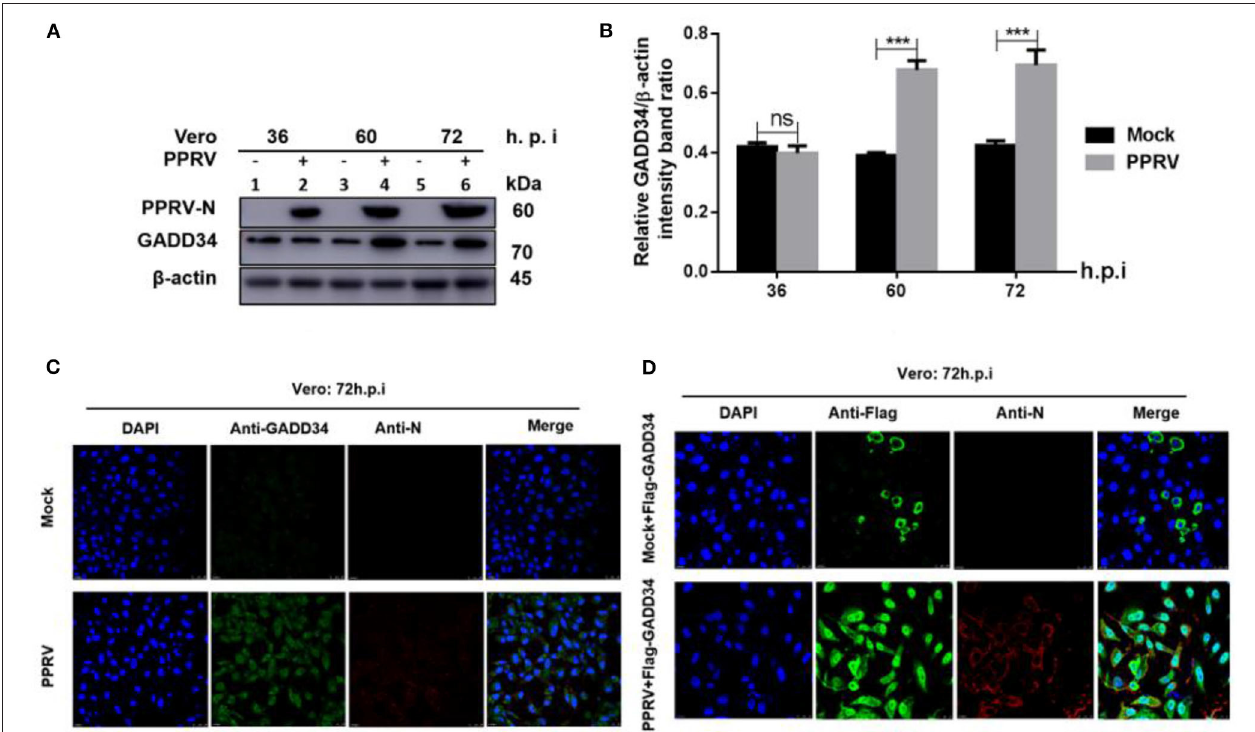
FIGURE 2 | PPRV infection modulates GADD34 protein expression in Vero cells. Vero cells were infected with PPRV or mock-infected at indicated times. (A) The effect of PPRV on GADD34 protein expression was analyzed by Western blot. (B) Densitometry quantification of GADD34 was normalized to β -actin and fold change was measured within each time point compared with mock-infected by ImageJ analysis. Statistical analysis was performed using GraphPad Prism 8 software. Shown are representative immunoblots and the error bars represent the mean ± SD from three independent experiments. Asterisks represent the statistically significant difference between mock and infected cells (*** P < 0.001 and ns, not significant). (C) Vero cells were infected with PPRV or mock-infected for 72h. (D) Vero cells were transfected with Flag-GADD34 (12h) before infection with PPRV or mock infection for a further 72h. Cells were double-stained with mouse monoclonal antibodies against PPRV N protein (1:50) and Rabbit anti-GADD34 antibodies (PA1-139) 1:100 in (C) or Rabbit anti-Flag (ab1162) 1:200 in (D) as primary antibodies overnight. Goat anti-rabbit IgG (H&L) Alexa Fluor 488 (ab150077) Green1:500 and Goat anti-mouse IgG H&L (Alexa Fluor 647) (ab150115) Red 1:1000 were used as secondary antibodies for 1h at room temperature. DAPI was used to stain the cell nuclei